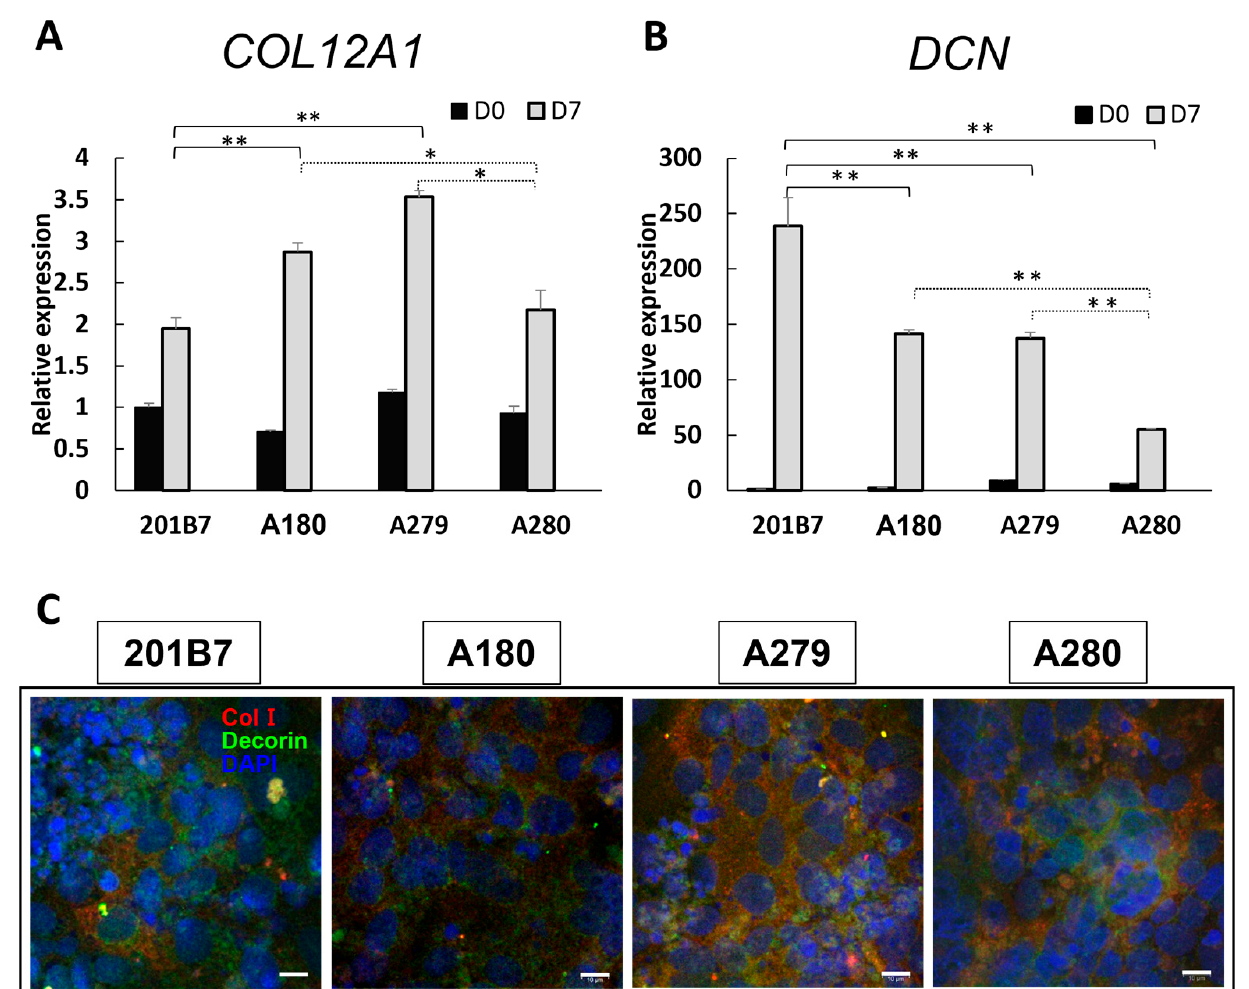
Figure 4. Expression of decorin and collagen in mcEDS- CHST14 iPSC-derived osteogenic lineages. ( A , B ) Gene expression of collagen ( COL12A1 ) and decorin ( DCN ) on Day 7, expressed as a value relative to that of WT iPSCs on Day 0. ( C ) Immunostaining of type I collagen (red) and decorin (green) on Day 7. Nuclei were counterstained with DAPI (blue). Scale bars, 10 µm. Data expressed as the mean ± SD ( n = 3); * p < 0.05, ** p < 0.01.